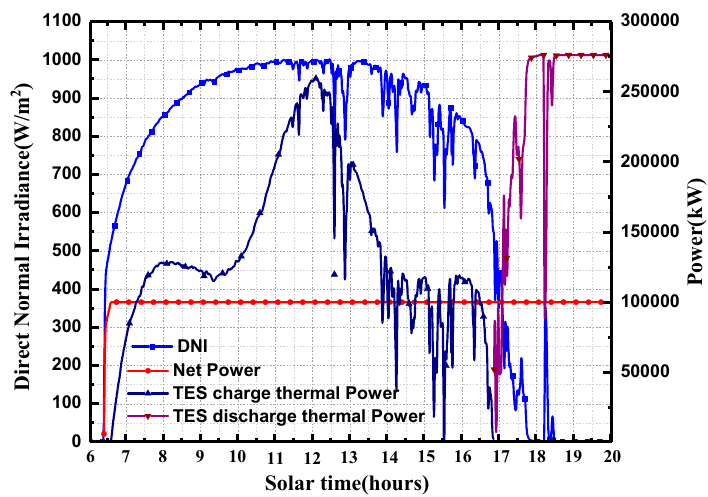
Figure 10. Performance results of the thermal storage on a cloudy day.